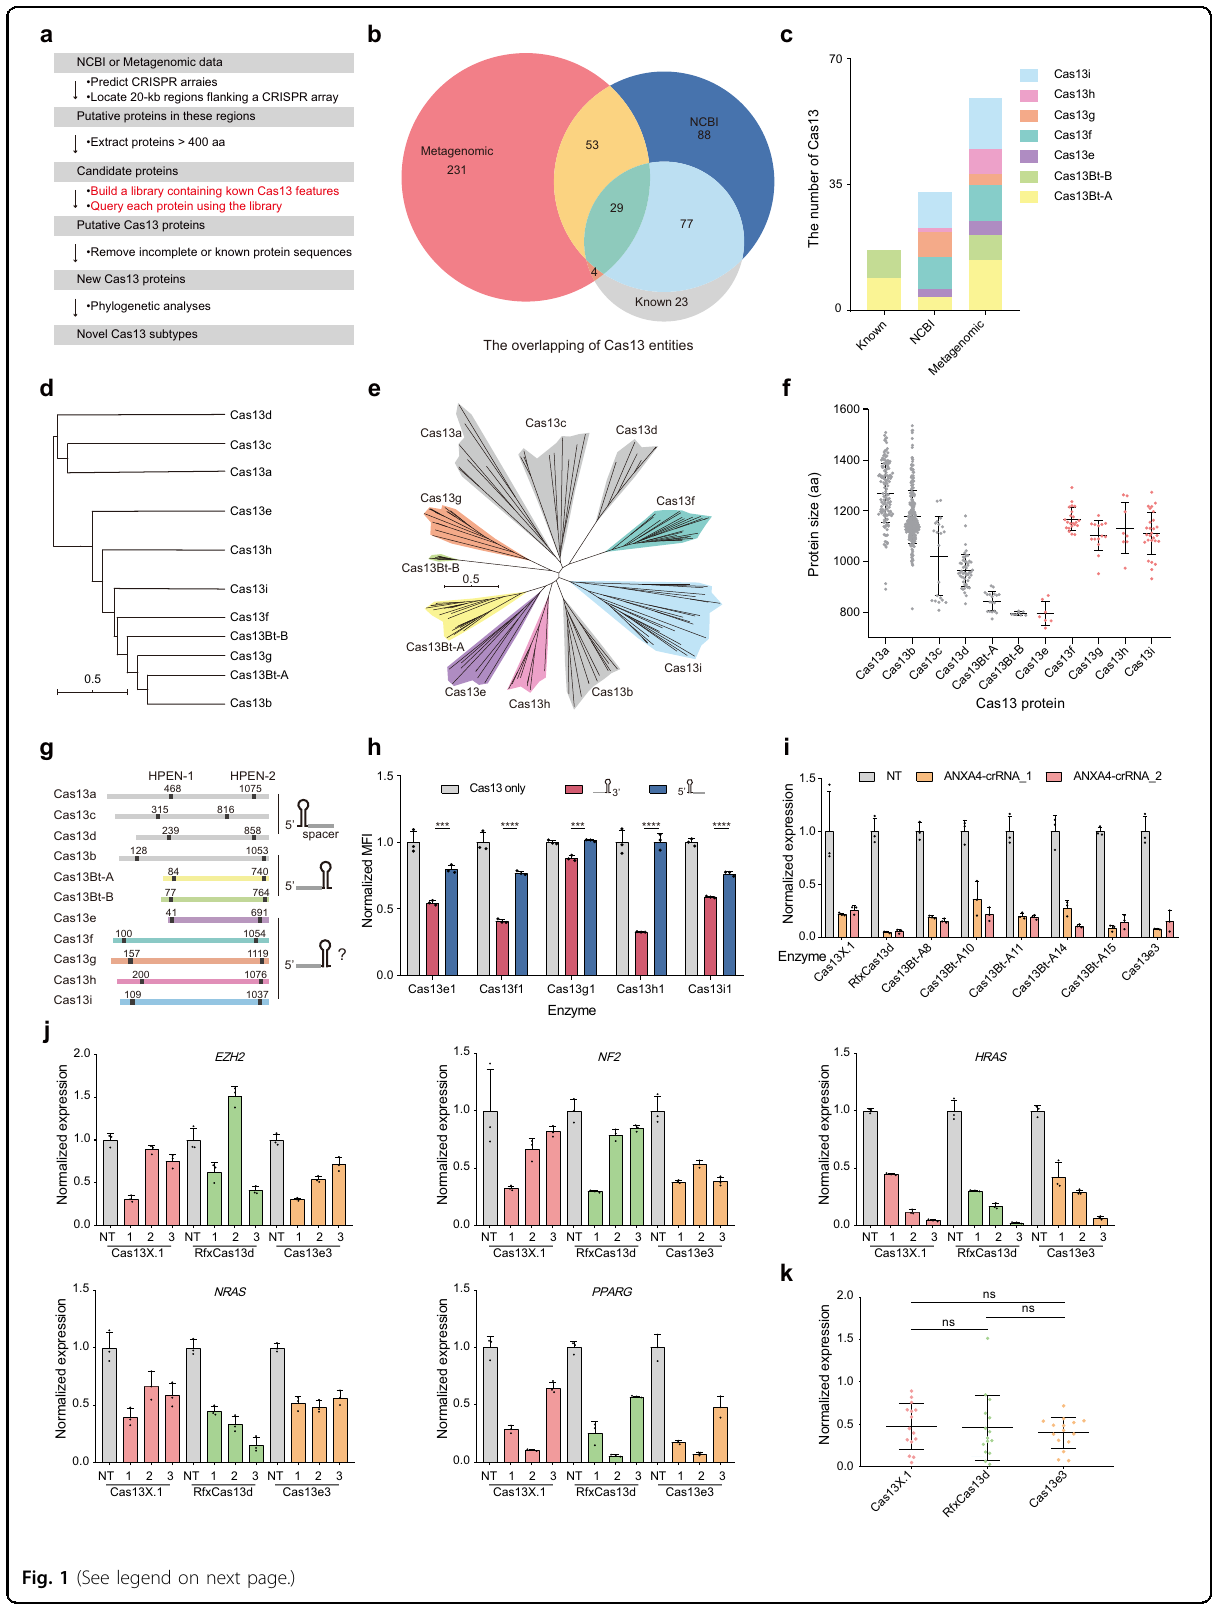
CRISPR arraies (cid:129)Locate 20-kb regions flanking a CRISPR array